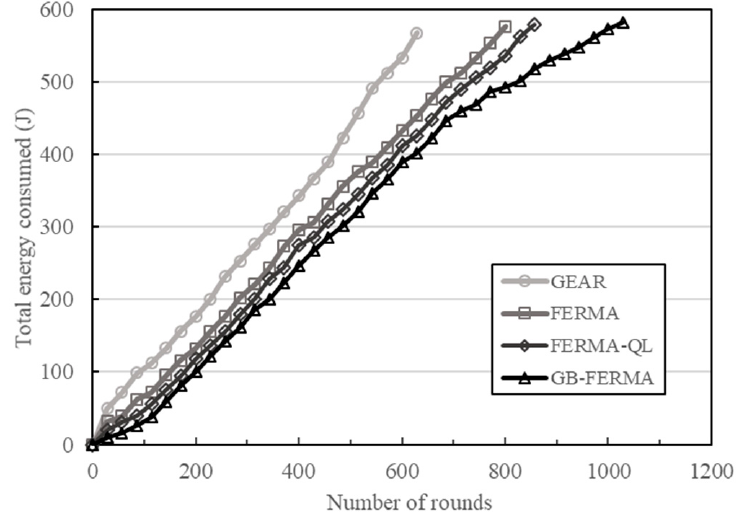
Figure 11. Total energy consumed versus number of rounds.